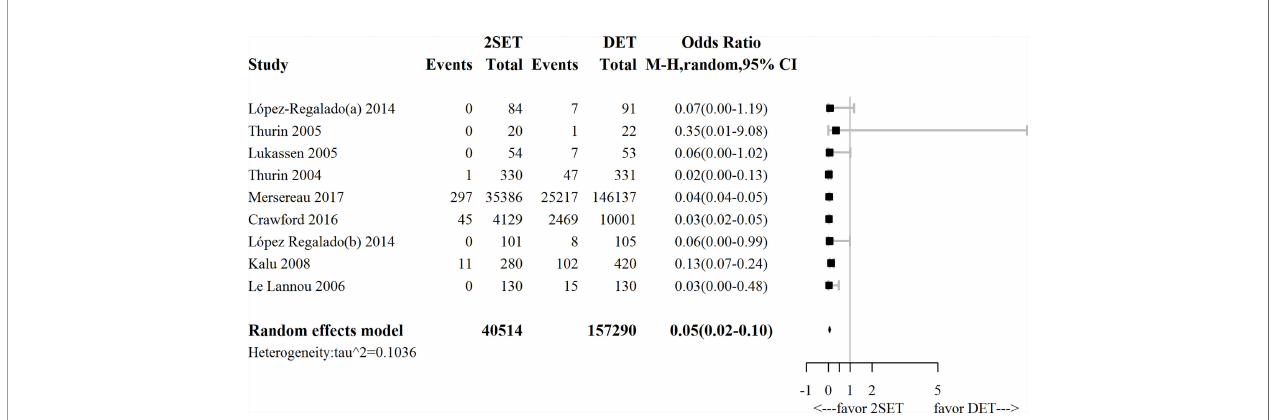
FIGURE 4 | Forest-plot comparing cumulative multiple live birth rate after two consecutive cycle of single embryo transfer (2SETs) and one cycle of double embryo transfer